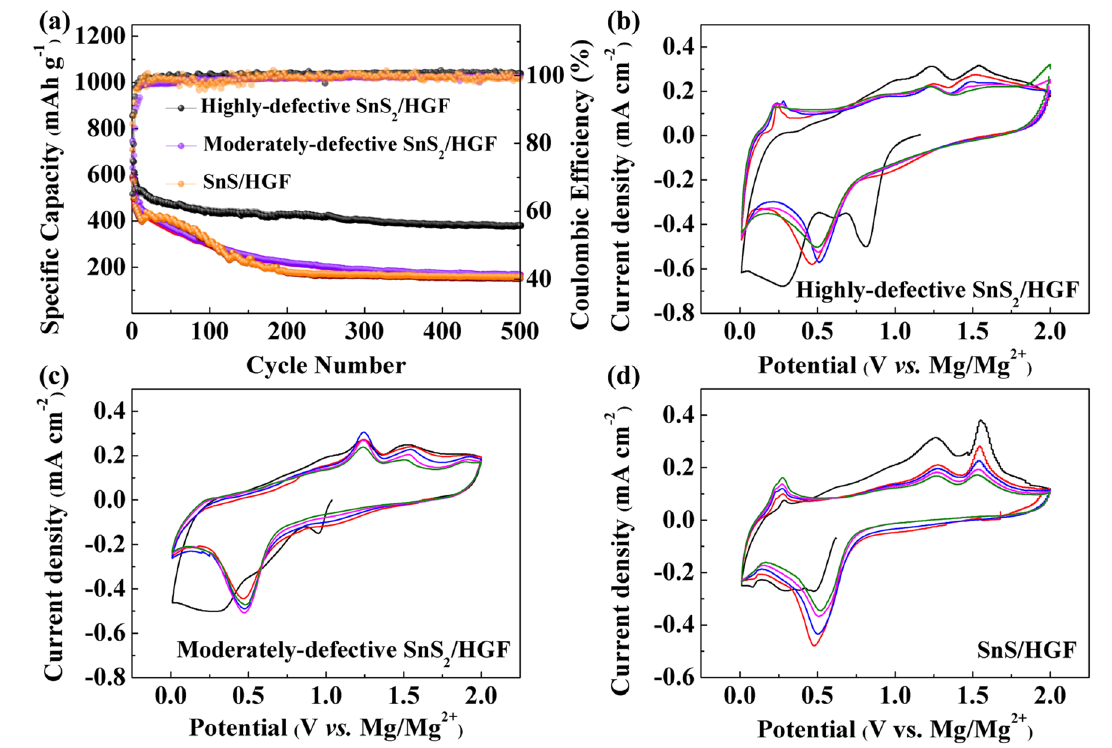
Fig. 4 Electrochemical properties of highly defective SnS 2 /HGF, moderately defective SnS 2 /HGF and SnS/HGF in MLHBs between 0.01–2.0 V vs. Mg 2+ /Mg. a Stability at 50 mA g −1 . b, c, d CV curves at 0.2 mV s.